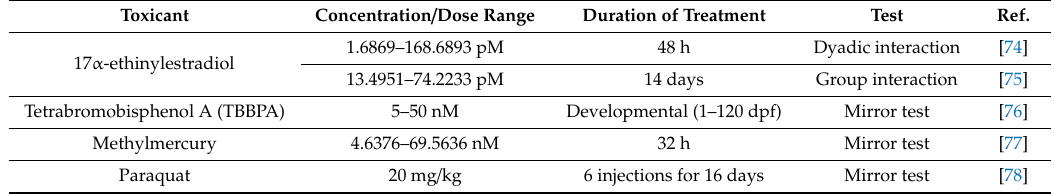
Table 4. Examples of toxicants that a ff ect aggressive and agonistic behavior in zebrafish behavioral bioassays. Concentrations were converted to molarity to facilitate